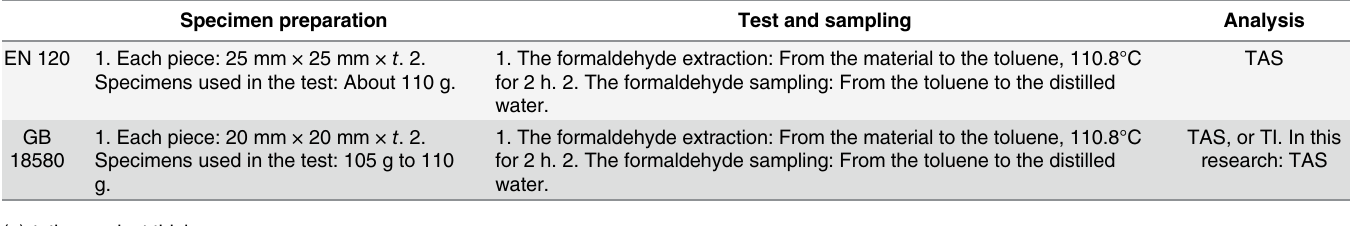
Table 2. Characterization of the Product Formaldehyde Emission: The Perforator Extraction Methods in Popular Standards and Chinese GB 18580. Specimen preparation Test and sampling